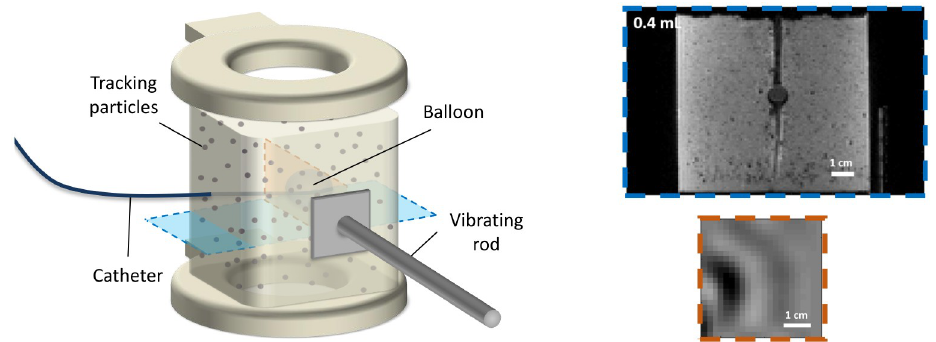
Fig 3. MR image acquisition. Schematic representation of the inflated balloon inside the phantom and of the vibrating rod used to generate the shear waves (left). A high-resolution MR image of the inclusion (coronal, blue dotted lines) and a wave image (sagittal, red dotted lines) are also shown